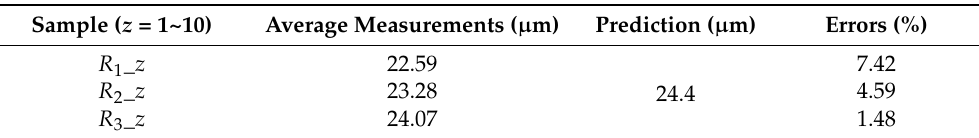
Table 3. The detailed results of SRVF-HB.